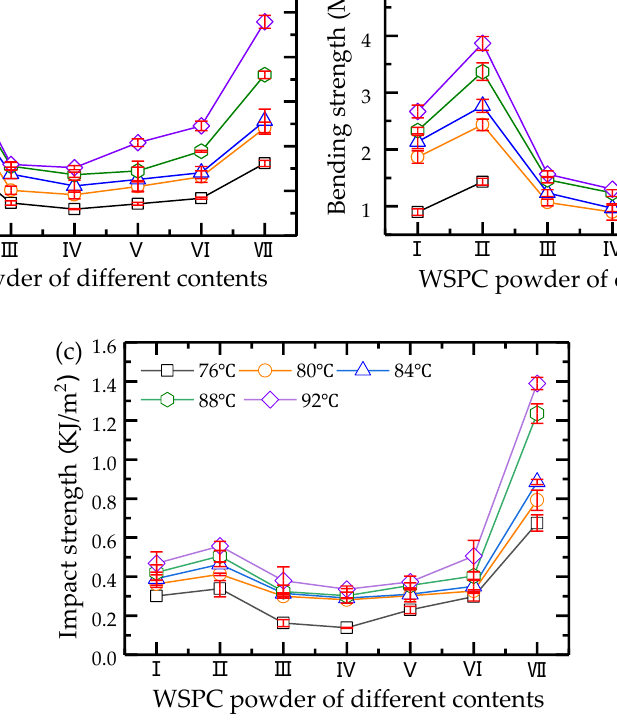
Figure 9. Mechanical properties changes of the WSPC parts: ( a ) tensile strength; ( b ) bending strength; ( c ) impact strength.